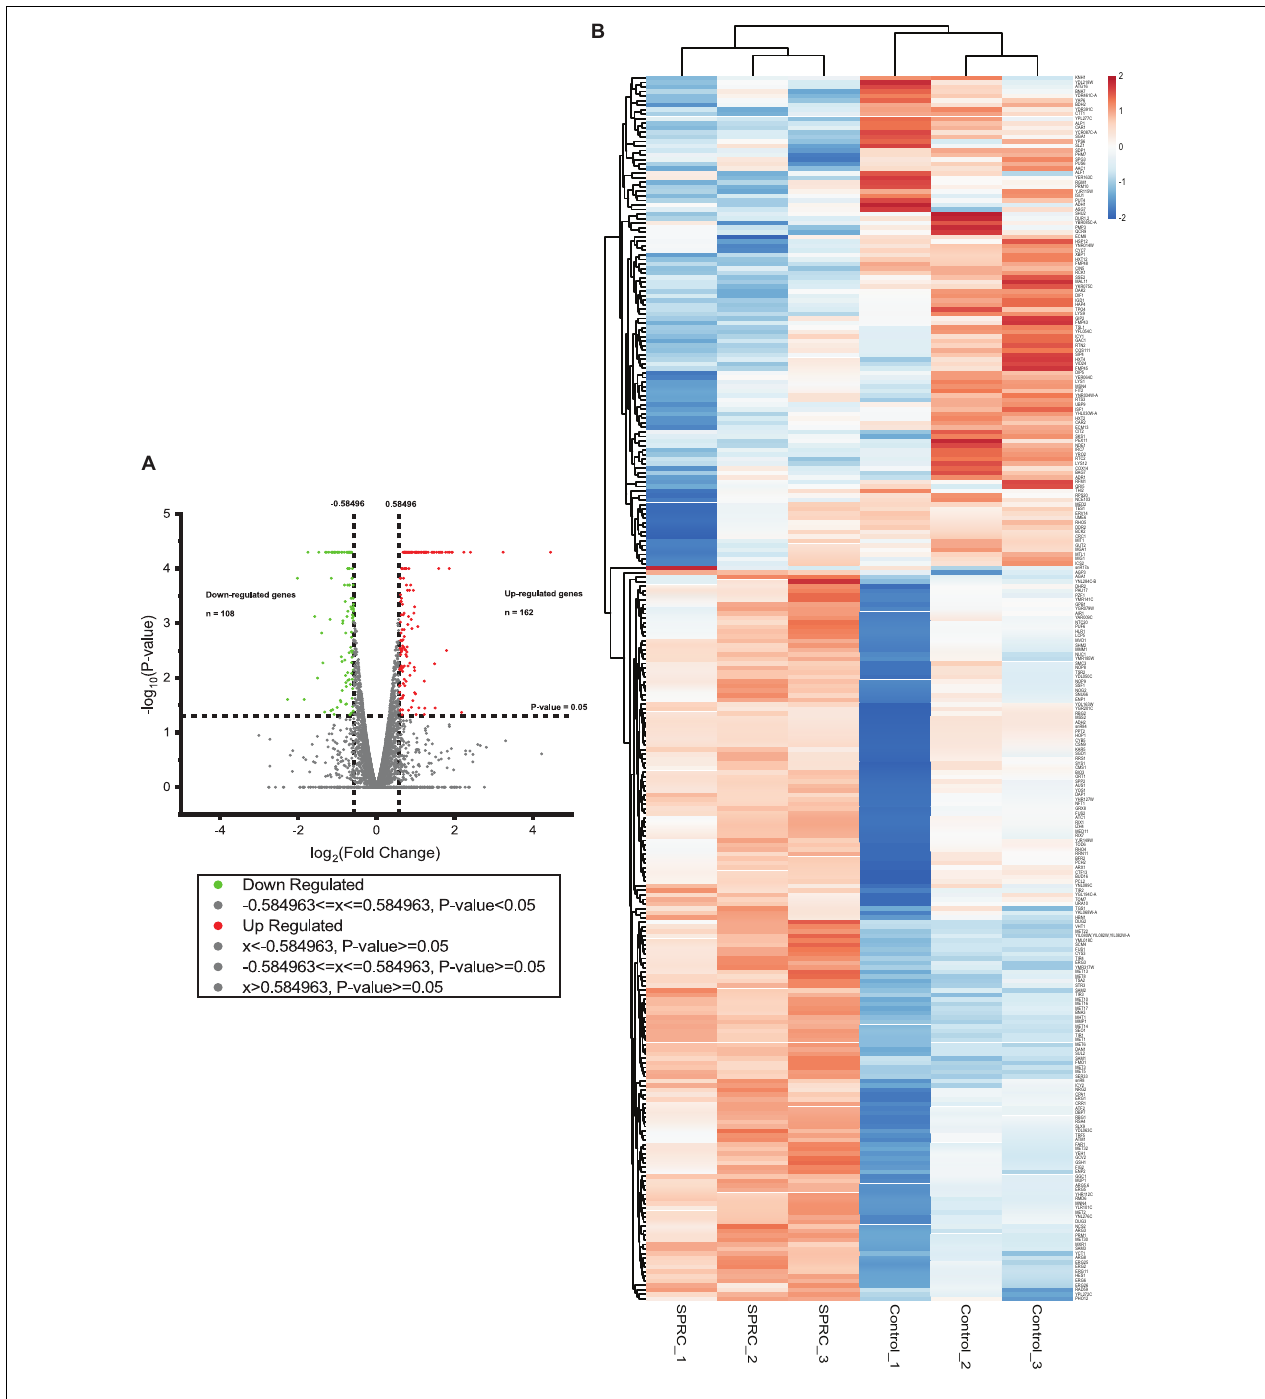
FIGURE 2 | The volcano plot and the heatmap of differentially expressed genes in response to SPRC display that SPRC-upregulated genes are more than SPRC-downregulated genes. (A) The volcano plot represents the differentially expressed genes under the SPRC treatment comparing with the control condition. The horizontal axis shows the value of log 2 (fold change) of each gene which is represented by a spot, and the cut-off values are set to ± 0.584963. The vertical axis shows the –log 10 ( p -value) of each gene calculated by the Cuffdiff program, and the cut-off value is set to p -value = 0.05. The number of SPRC-upregulated genes colored in red is 162, whose p -values are smaller than 0.05. The number of SPRC-downregulated genes colored in green is 108, whose p -values are smaller than 0.05. (B) The heatmap of the enrichment of the differentially expressed genes under the SPRC treatment comparing with the control condition whose log 2 (fold changes) are larger than +0.585 or smaller than –0.585. The enrichment illustrates a good triplicates situation and more SPRC-upregulated genes than SPRC-downregulated genes. The legend of the color bar displays the log 2 values of the fold change of each replicate of each gene, from –2 to 2.